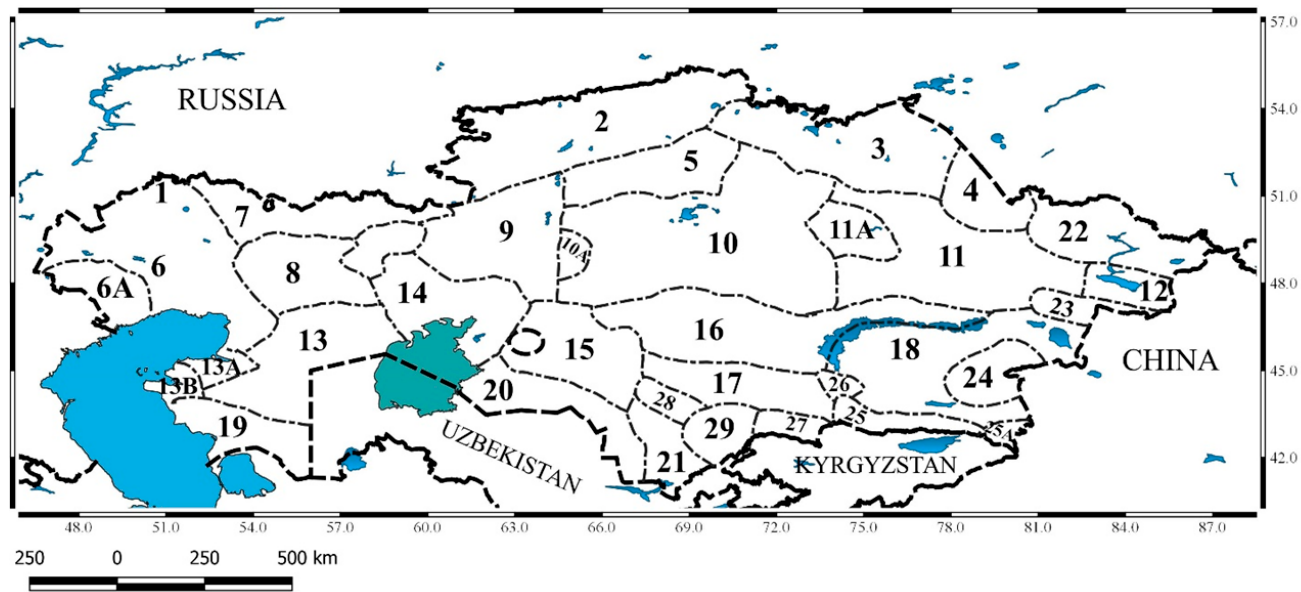
Figure 1. Map of floral zoning of Kazakhstan. 1. Spurs of the General Syrt; 2. Tobol-Ishim; 3.